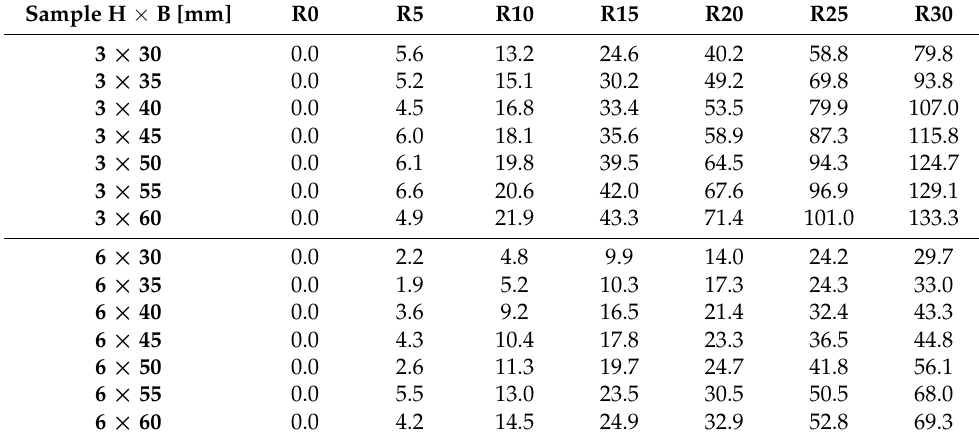
Table 4. Results of the bench experiment. Summary of the percentage value of the K stiffness increase index, depending on the test package (H × B) and expansion R